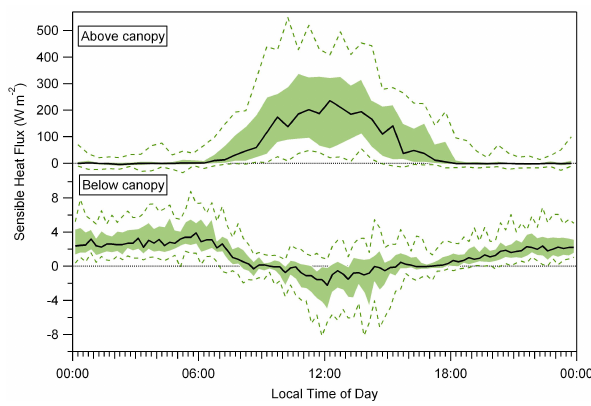
Fig. 2. Diurnal variation of sensible heat flux above the canopy (at the GAW tower) and in the trunk space. Shown are the median values at given times of day (black line), inter-quartile ranges (green shaded region) and 10th and 90th percentiles (dashed